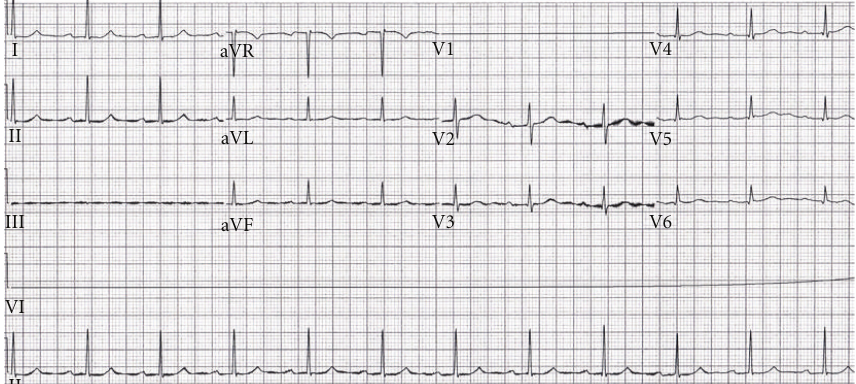
Figure 3: ECG following resolution of hyperkalemia, with first-degree AV block (PR interval 232 ms) and resolution of peaked T